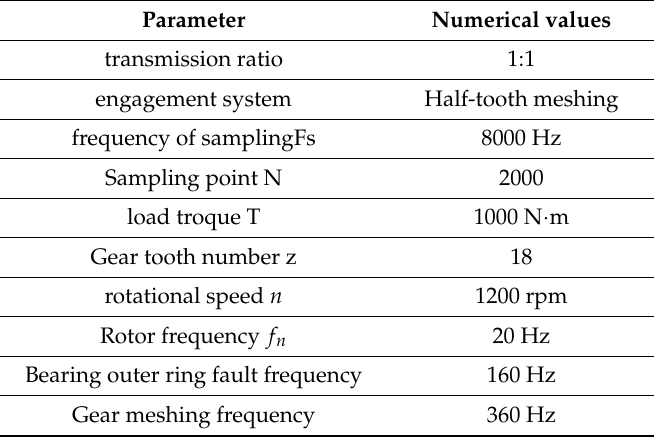
Table 2. Experimental parameters.